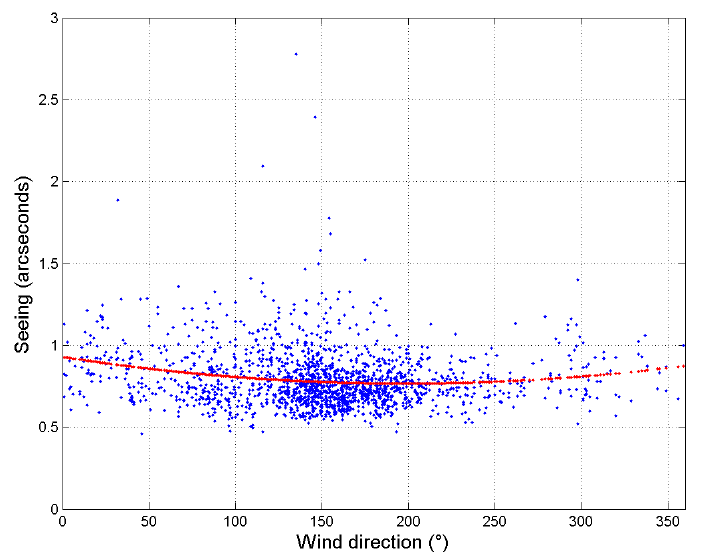
Figure 7. Correlation of seeing and wind direction.